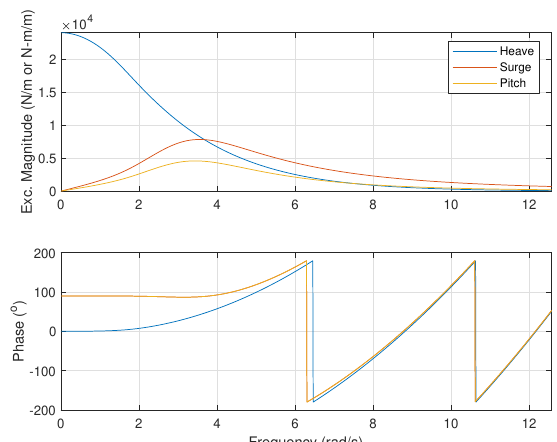
Fig. 3: The surge, heave, and pitch excitation of the WaveBot